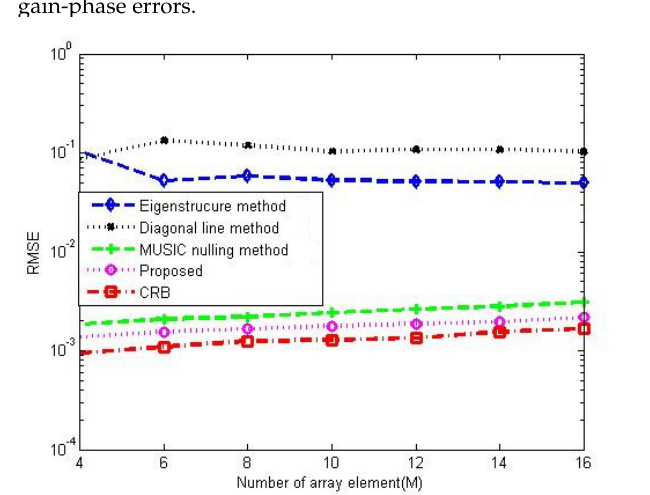
Figure 8. RMSE performance comparison among the Eigenstructure method [13], Diagonal line method [17] and MUSIC nulling method [25] versus SNR, CSR = 30 dB, K 0 = 20, T = 80, N = 40. ( a ) In 5-element ULA with deterministic gain-phase errors. ( b ) In 16-element ULA with random gain-phase errors.